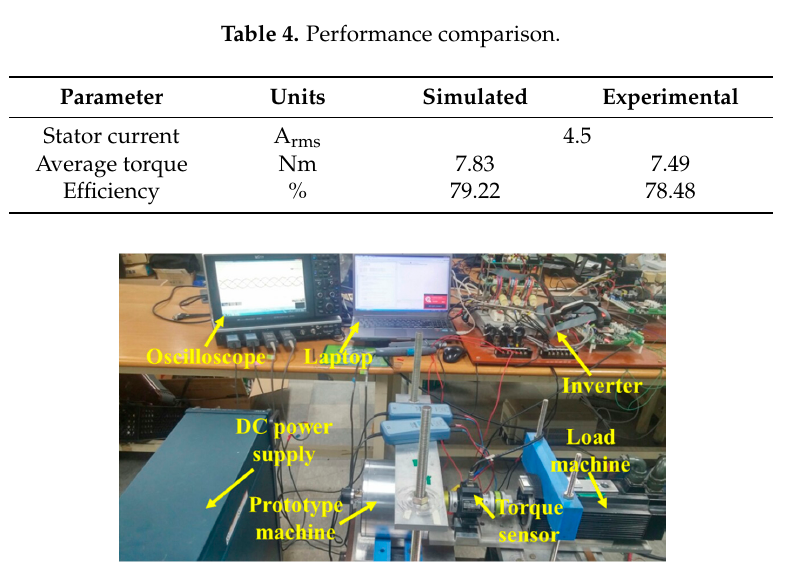
Figure 19. Experimental setup. Energies 2018 , 11 , x FOR PEER REVIEW